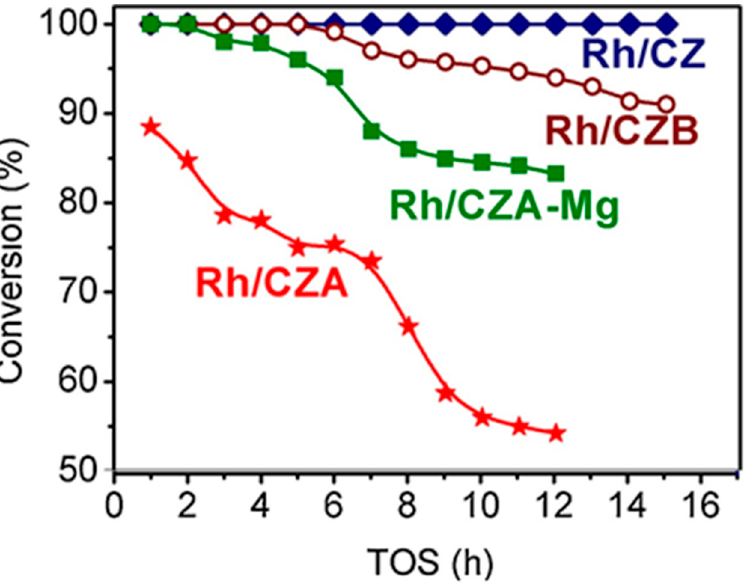
Figure 4. The time dependence of HD conversion under the following SR conditions: GHSV = 23,000 h –1 , H 2 O/C = 3, T = 550 °C [50].